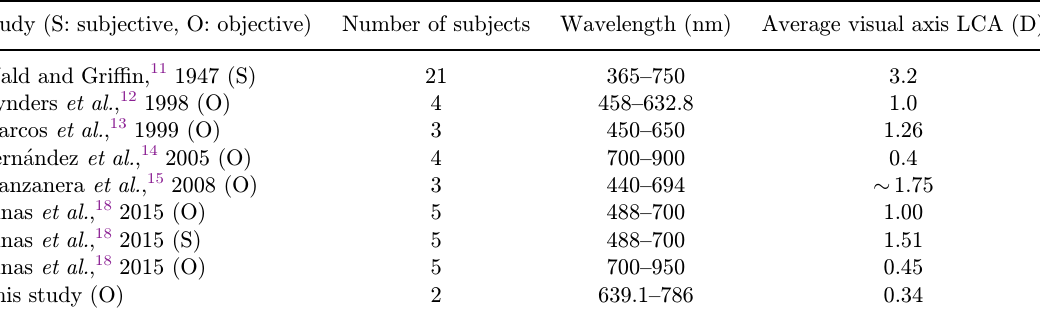
Table 6. LCA data reported in previous studies.